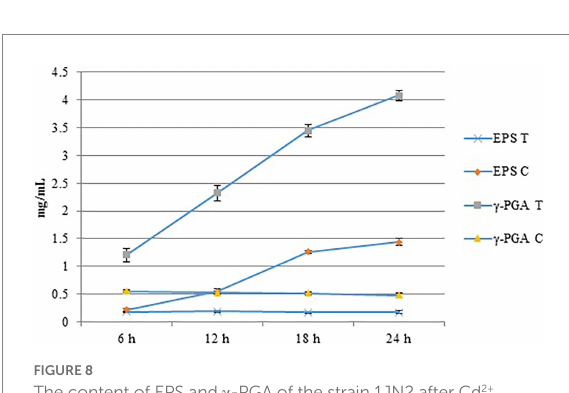
FIGURE 8 The content of EPS and γ -PGA of the strain 1JN2 after Cd 2+ treatment. 3 mM Cd 2+ was added in the broth and the supernatants at 6, 12, 18 and 24 h after inoculation were used to detect the content of EPS and γ -PGA. T means treated with Cd 2+ and C means control without Cd 2+ .